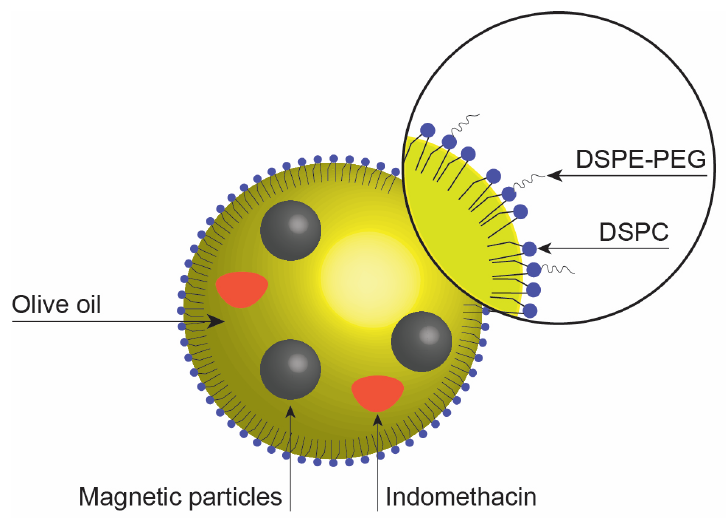
Figure 1. Schematic representation of a droplet of any magnetic nanoemulsion.